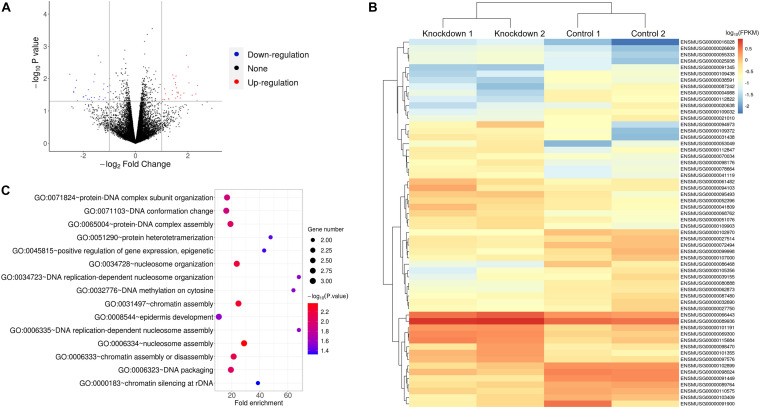
RNA-Seq analysis of HT22 cells upon GAS5 KD revealed that the affected genes might participate in cell cycle. (A) Volcano plot for differentially expressed genes (DEGs) between control and GAS5 KD groups. (B) Heatmap of the 58 DEGs with the highest significance levels between control and GAS5 KD groups. Key of heatmap represented the log10(FPKM) of 58 DEGs. (C) Gene ontology enrichment analysis for “Biological Process” of upregulated DEGs in GAS5 KD group.